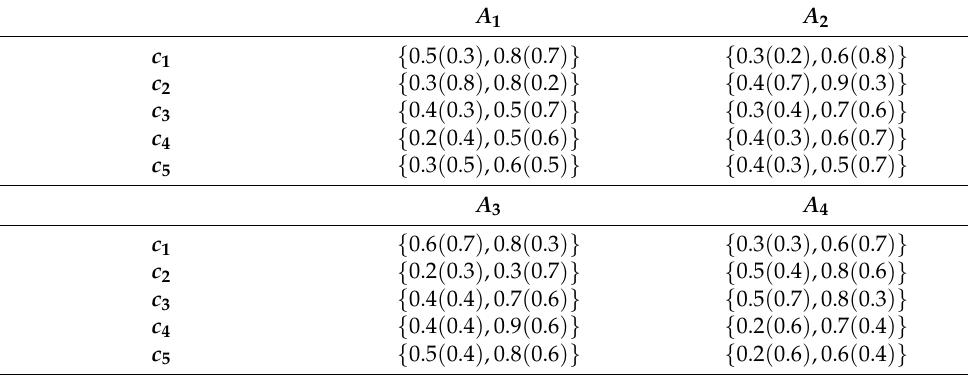
Table 2. Original evaluation matrix of Expert 2 ( d 2 ).